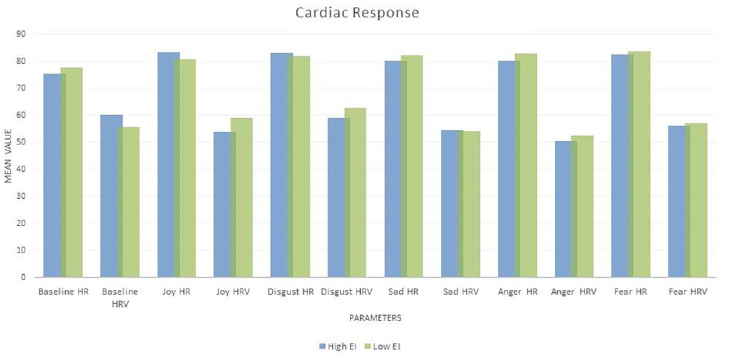
Fig 4. Mean cardiac response of high and low EI